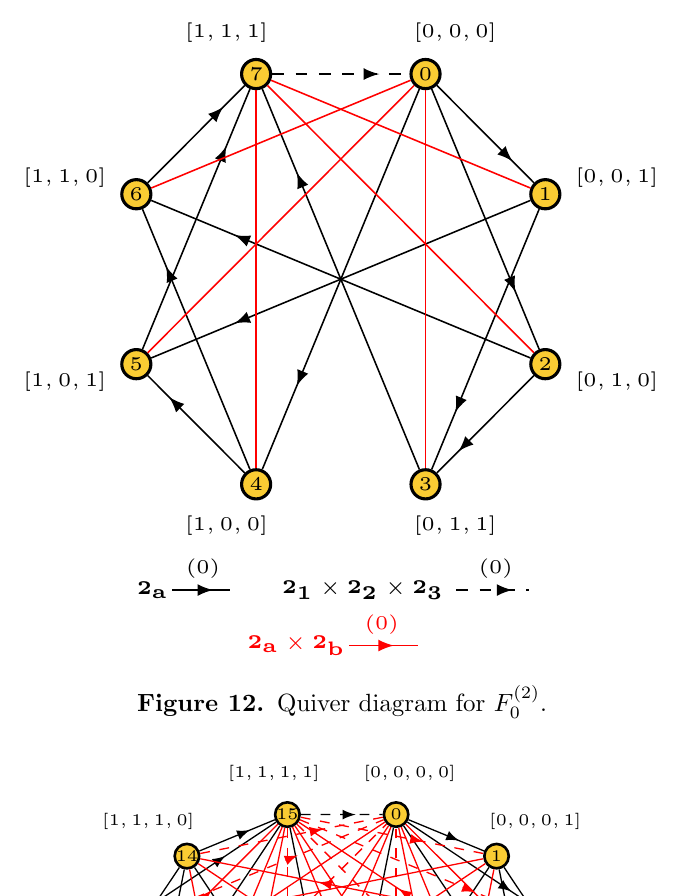
Figure 12. Quiver diagram for F (2)